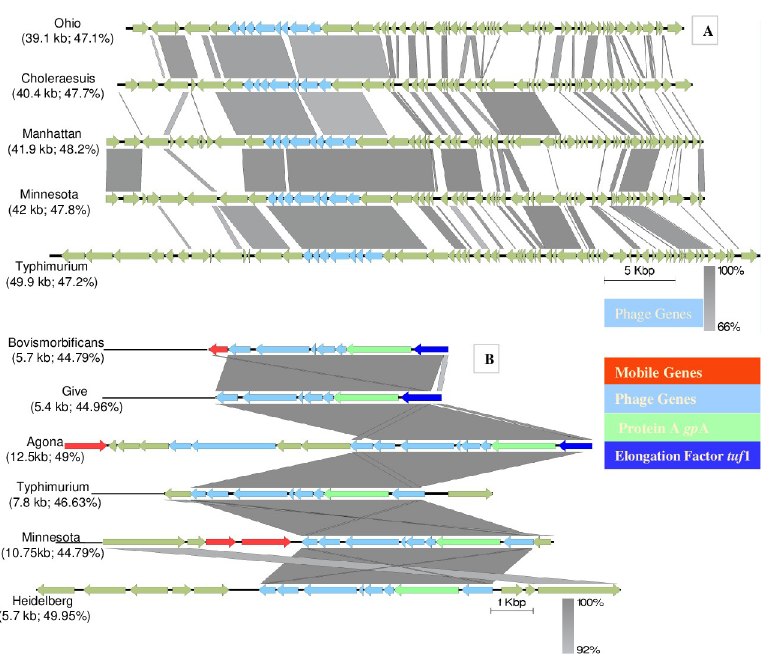
Fig 6. Alignment of closely homologous intact integrated phage among Salmonella serotypes. A. Phage genes synteny in five serotypes. B. Phage gene arrangement along with mobile genes (transposase, recombinase) in six serotypes. The arrow shows orientation of the genes and genes are color coded to define mobile, phage and other genes.